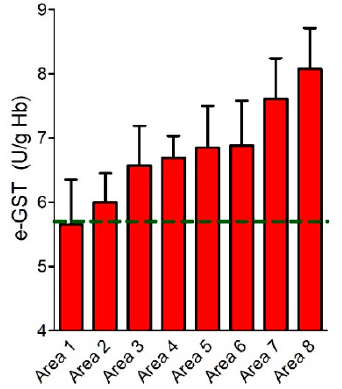
Figure 10. Erythrocyte glutathione transferase (e-GST) activity in the Sacco River valley. e-GST activity in the population of eight selected areas monitored (area 1–8, red bars) compared to the e-GST activity reference value for the Rome area (dotted green line) (modified from Reference [177] ).